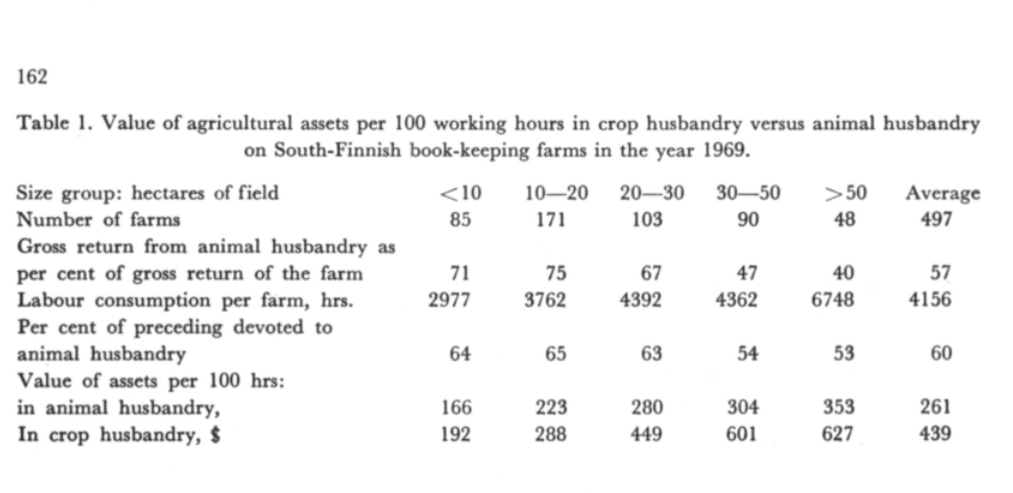
Table 1. Value of agricultural assets per 100 working hours in crop husbandry versus animal husbandry on South-Finnish book-keeping farms in the year